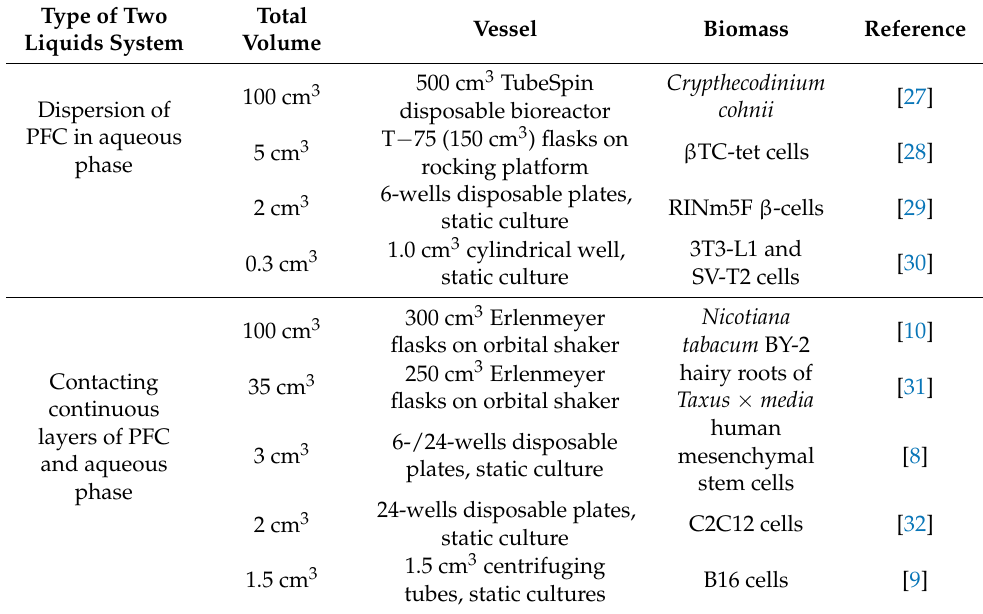
Table 4. Examples of two-liquid culture systems integrating immiscible aqueous culture media and dispersed or layered liquid PFCs.